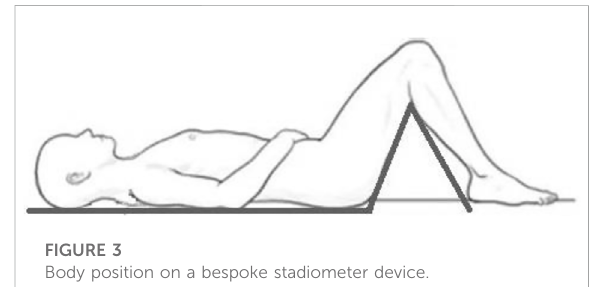
FIGURE 3 Body position on a bespoke stadiometer